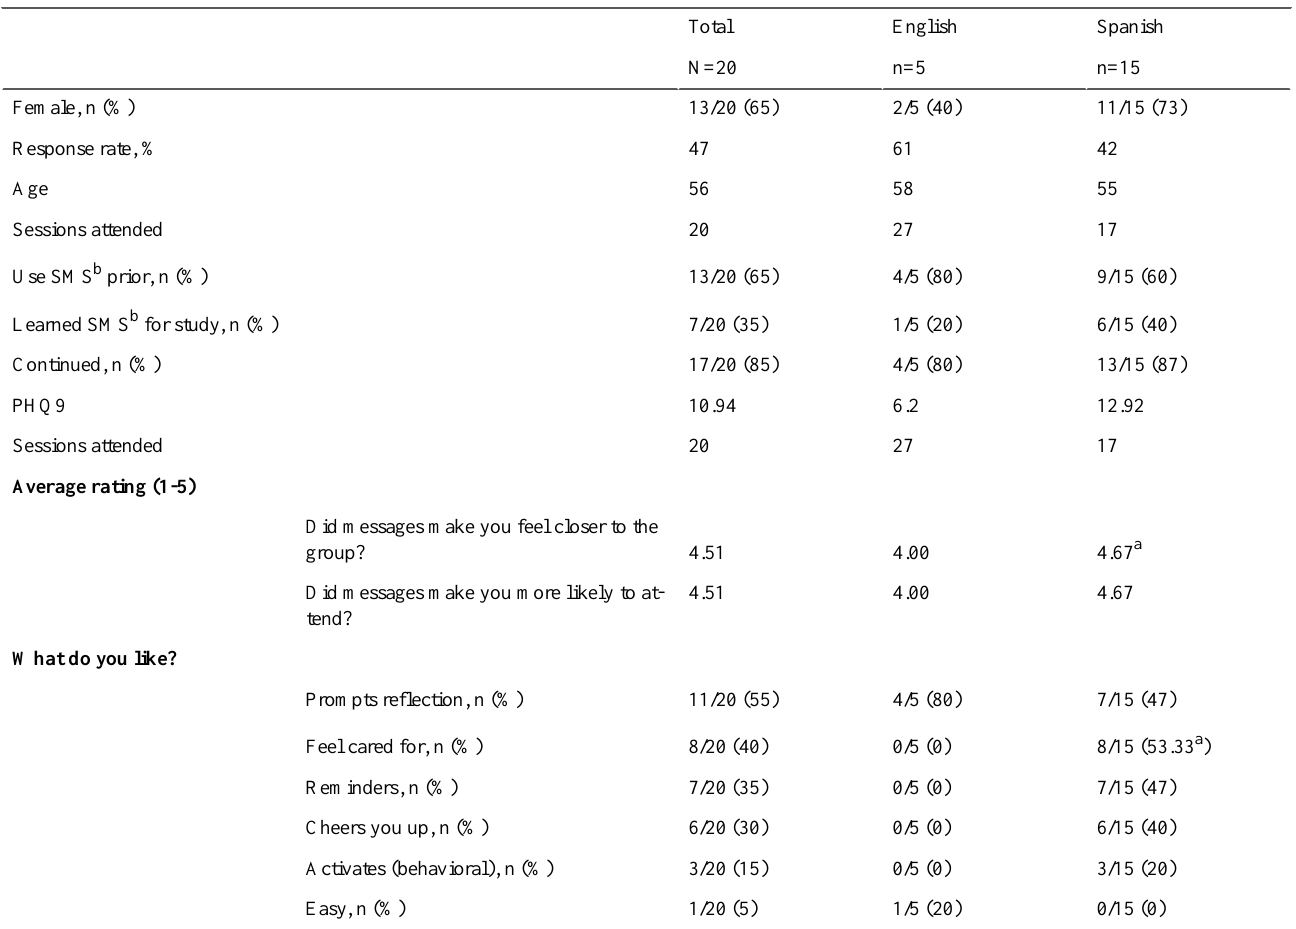
Table 2. Language